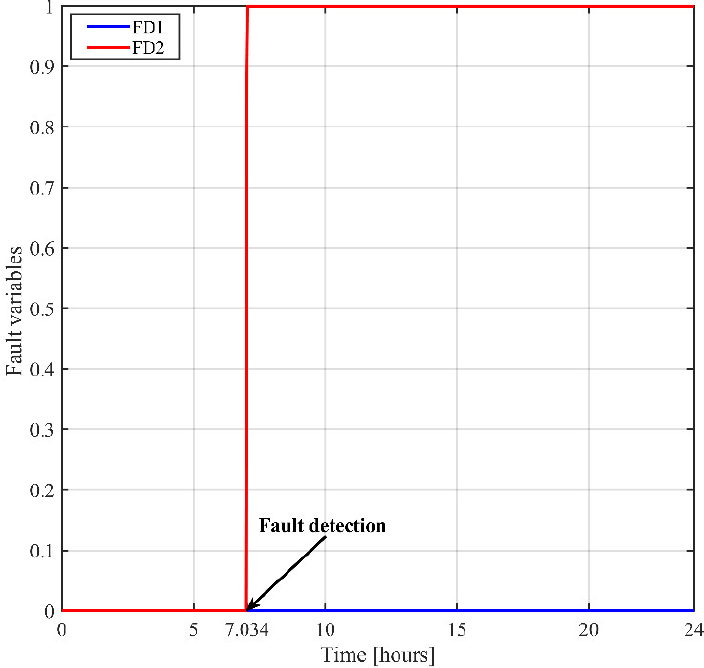
Figure 26. Fault variables.